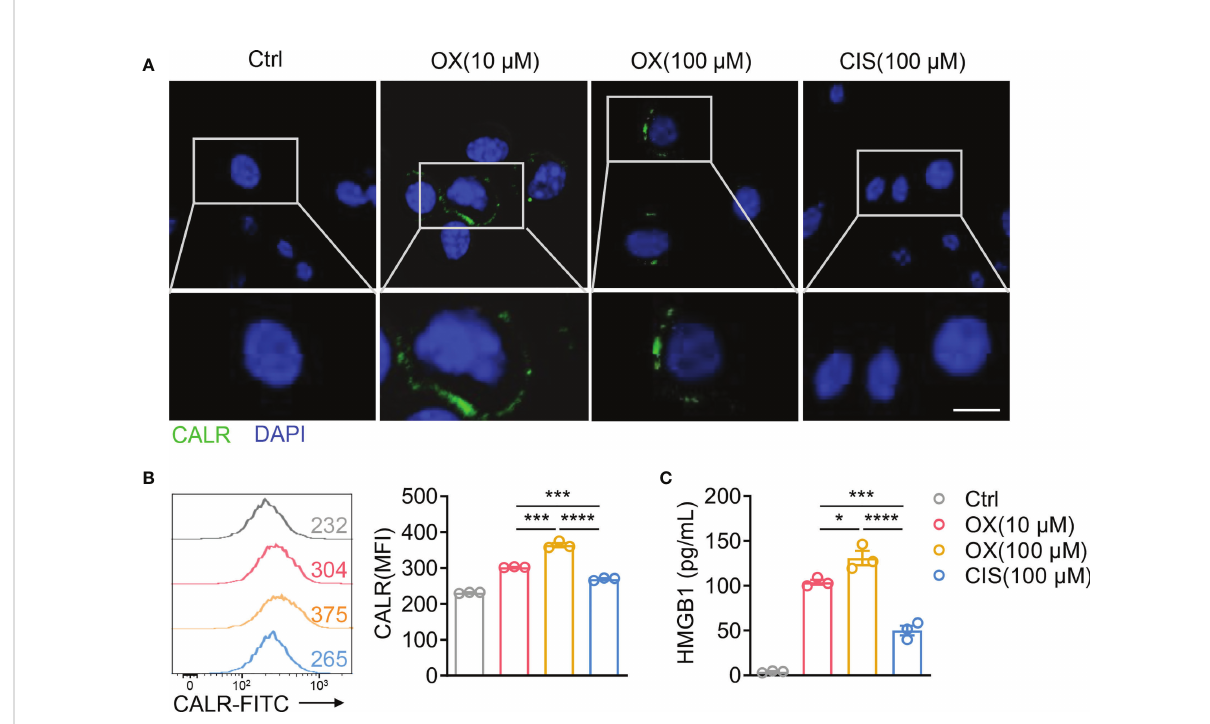
FIGURE 7 Oxaliplatin induces immunogenic cell death of CT26 colon cancer. (A) , Representative immuno fl uorescence staining of calreticulin (CALR) in CT26 cells after treatment with various dose OX or CIS for 4 h. Scale bar represents 10 m m. (B) , Representative histogram of CALR expression on CT26 cells after treatment with various dose OX or CIS for 4 h (left). Mean fl uorescent intensity (MFI) of CALR expression on CT26 were also shown (right). (C) , HMGB1 concentration in the supernatants of CT26 cells treated with various dose OX or CIS for 24 h. Data were representative of at least two independent experiments. Error bars represent means ± SEM. Statistical signi fi cance was determined using unpaired two-tailed t-test (B, C) . *p < 0.05; ***p < 0.001 and ****p < 0.0001.